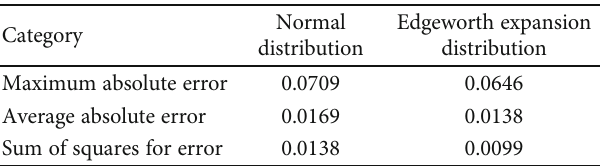
Figure 2: Comparing the Edgeworth series travel time probability density function and histograms. Table 1: Error analysis of travel time estimation in early peak section.